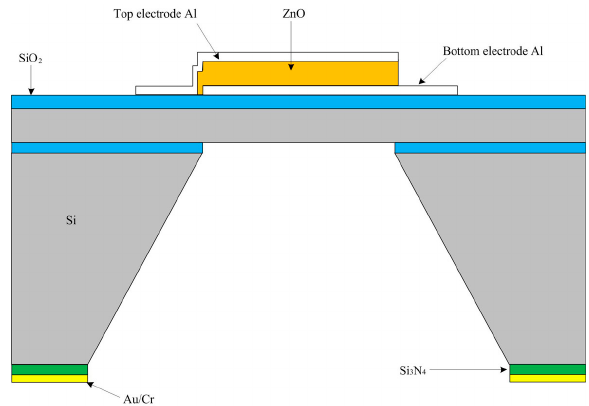
Figure 2. Schematic structure of the piezoelectric micromachined ultrasound transducer.